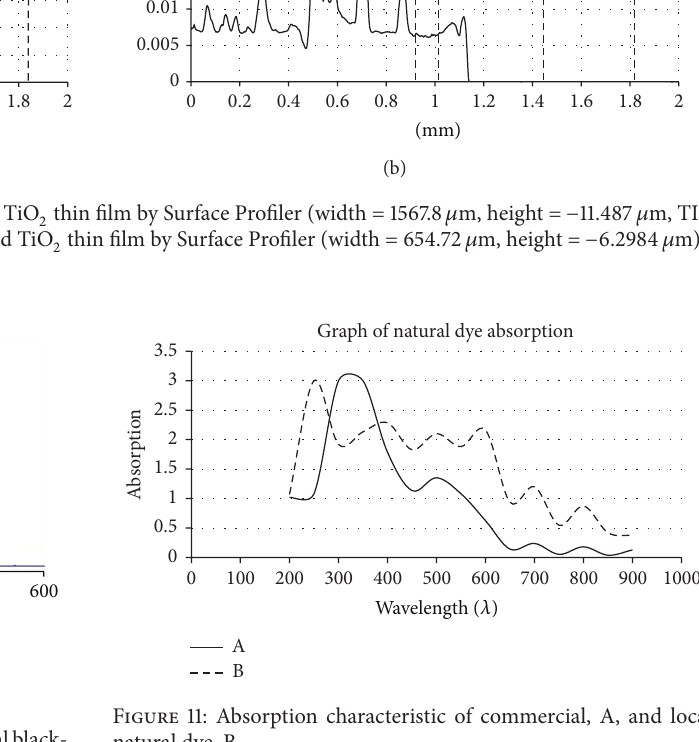
Figure9:Functionalgroupcomparisonbetweencommercialblack- berry dye and local natural dye, Senduduk ’s fruit.